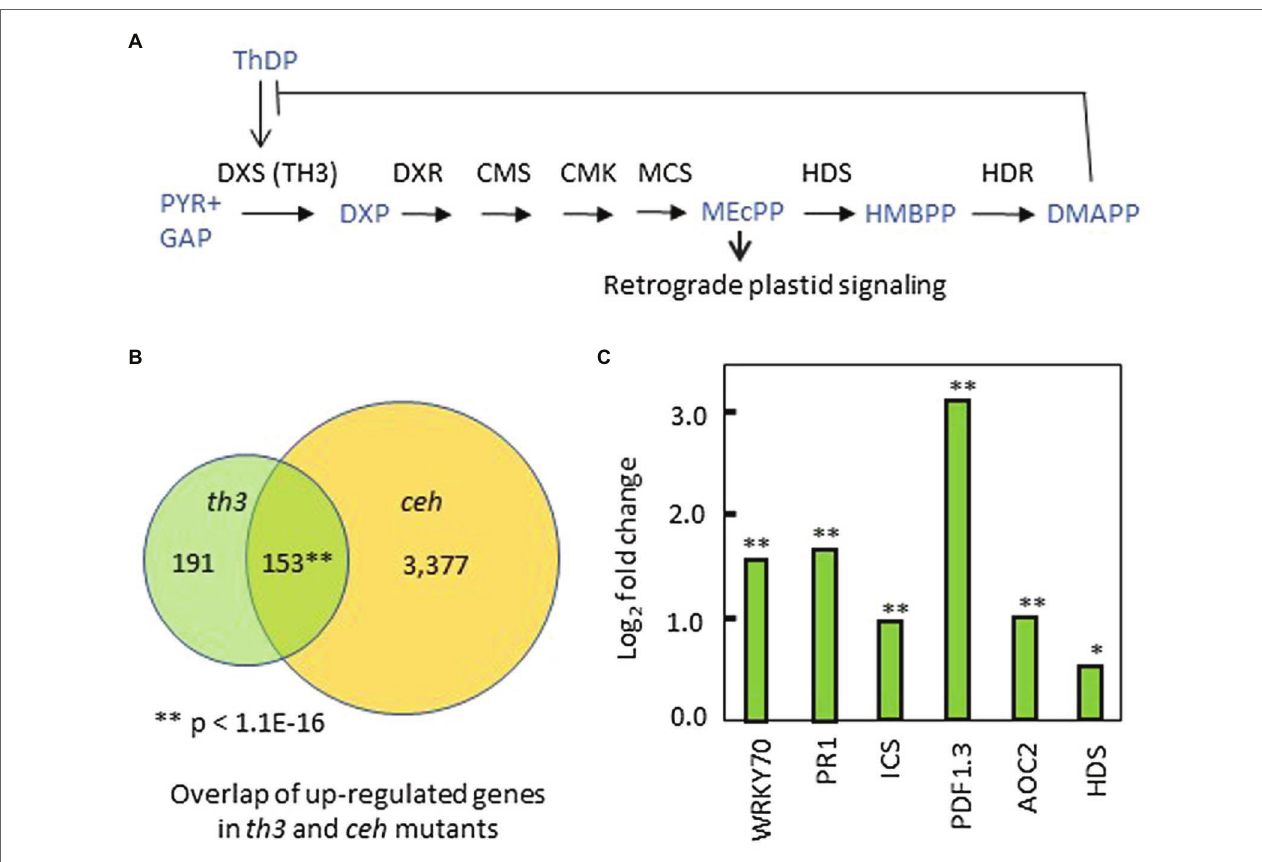
FIGURE 5 | Perturbation of the MEP pathway and plastid signaling by th3 . (A) Mechanisms of regulation in the MEP pathway include DMAPP inhibition of ThDP binding to DXS1 (Banerjee et al., 2013) and retrograde signaling by the MEcPP intermediate (Xiao et al., 2012; Benn et al., 2016). (B) Venn diagram showing overlap of genes upregulated in th3 and ceh mutants (Bjornson et al., 2017) above a cutoff of 1.5-fold change (log 2 fold change > 0.587) in both datasets. **Value of p for gene enrichment based a binomial statistic. (C) Genes upregulated in thiamin rescued th3 plants ( Supplementary Table S1 ) include a suite of biotic stress-related genes also induced by HDS mutations that accumulate MEcPP (Bjornson et al., 2017). Fold changes in exemplar biotic stress-response genes are shown. In addition, HDS is the sole MEP pathway gene differentially affected by th3 . DXS1, deoxyxylulose-phosphate synthase; DXR, DXP reductoisomerase; CMS, 2-C-methyl-D-erythritol 4-phosphate cytidylyltransferase; CMK, 4-diphosphocytidyl-2-C-methyl-D-erythritol kinase; MCS, 2-C-methyl-D-erythritol 2,4-cyclodiphosphate synthase (MEcPP); HDS, (E)-4-Hydroxy-3-methyl-but-2-enyl pyrophosphate (HMBPP) synthase; HDR, HMB-PP reductase; and DMAPP, Dimethylallyl pyrophosphate. Significant at * p < 0.05; significant at ** p <